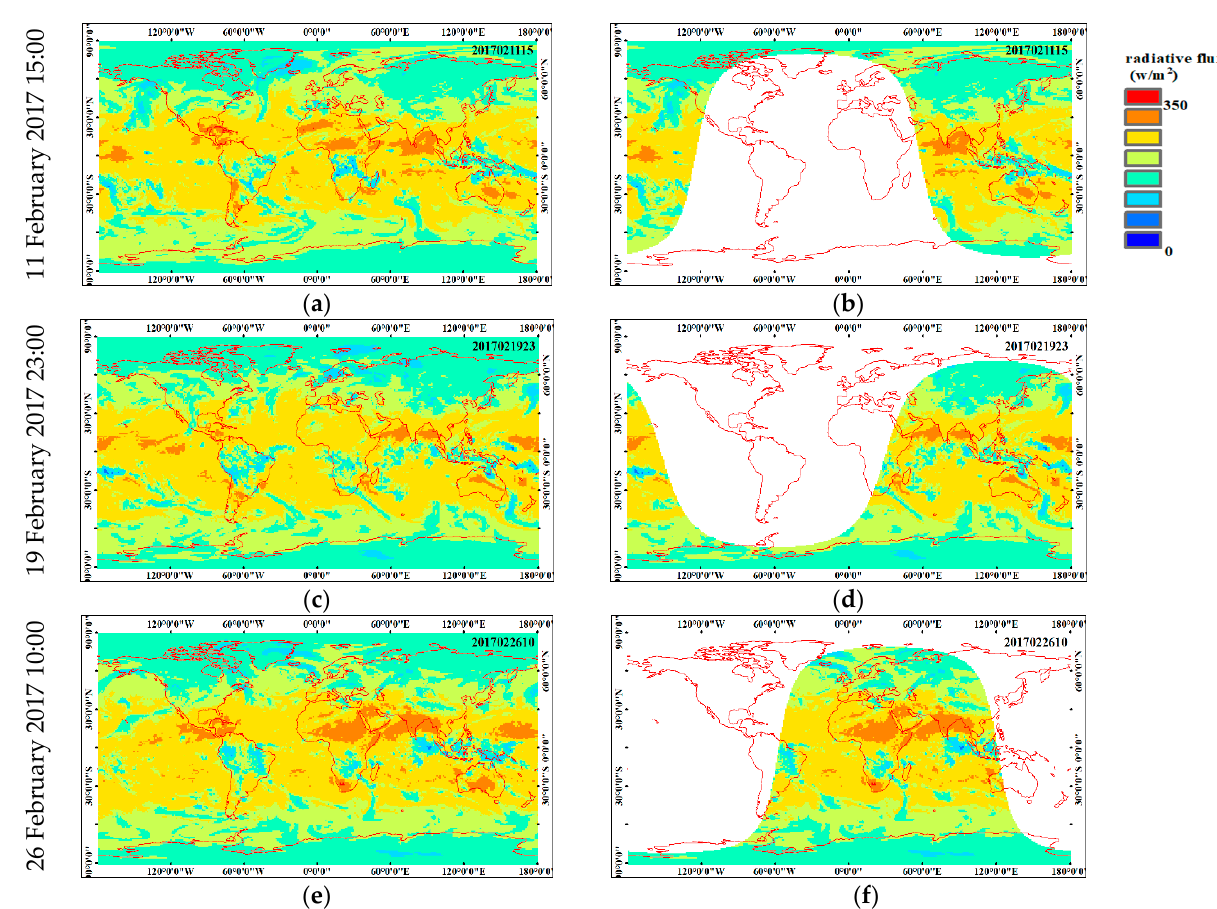
Figure 9. The hourly TOA outward longwave radiative flux of the whole Earth derived from ERA5 (images in the first column, i.e., a , c , e ) and the hourly TOA outward longwave radiative flux of the Earth surface in the Moon-based view (images in the second column, i.e., b , d , f ). The images in each row were obtained at the same UTC time.